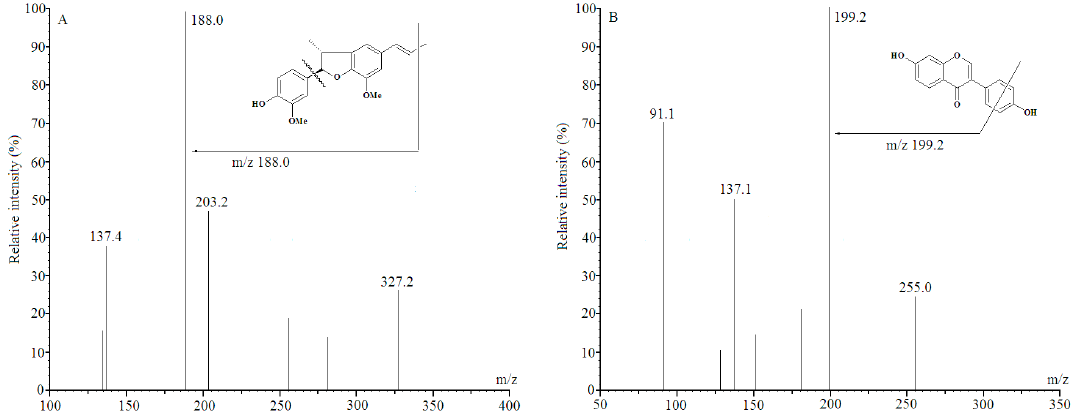
Figure 1. The positive ion scan spectra of DDIE ( A ) and daidzein (I.S.) ( B ).